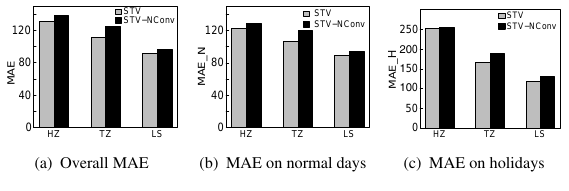
Fig. 7 MAE comparison on the convolution layer.